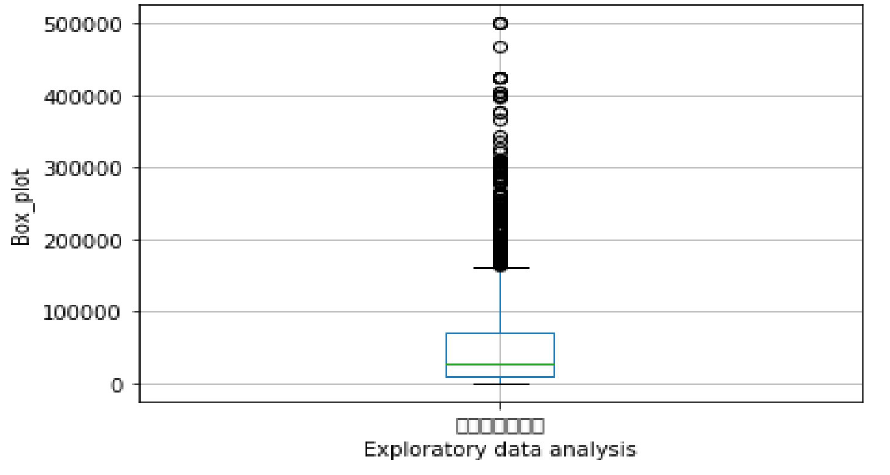
Fig 16. Exploratory data analysis for credit limit (A22).